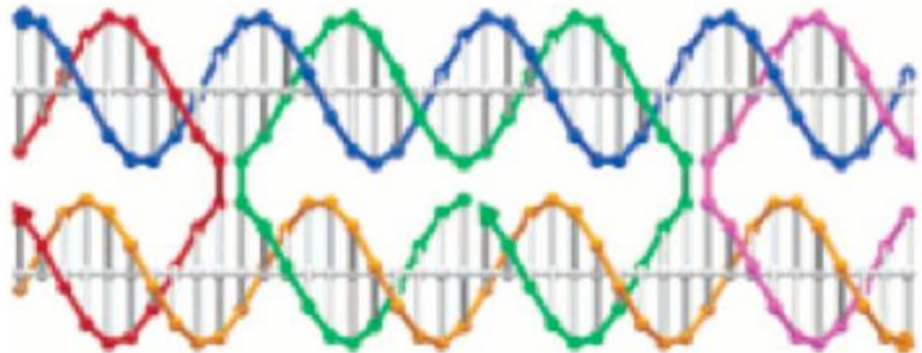
Figure 38. A DX DNA schematic. The color is different for each individual strand of DNA. The location of any phosphate is represented by small circles and the upright grey lines are the base-pairs. The red, green and pink strands overlap between the two double helices. Reprinted with reference authorisation [247], Copyright 2004,